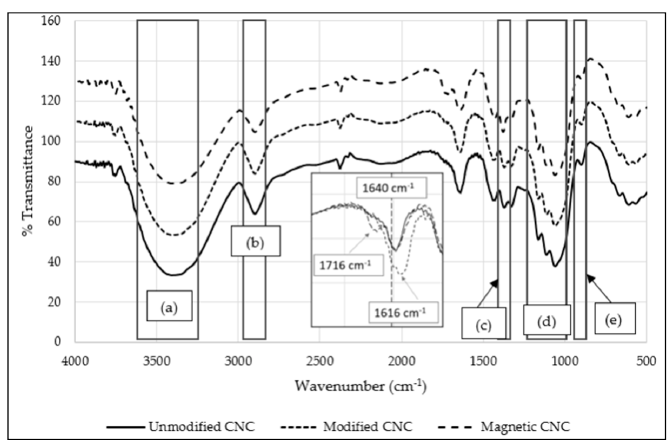
Figure 2. FTIR spectra of CNCs, modified CNCs and magnetic CNCs. (Inset showing expanded portion of wavelength 1600–1800 cm − 1 , where the peak shift is clearly seen).